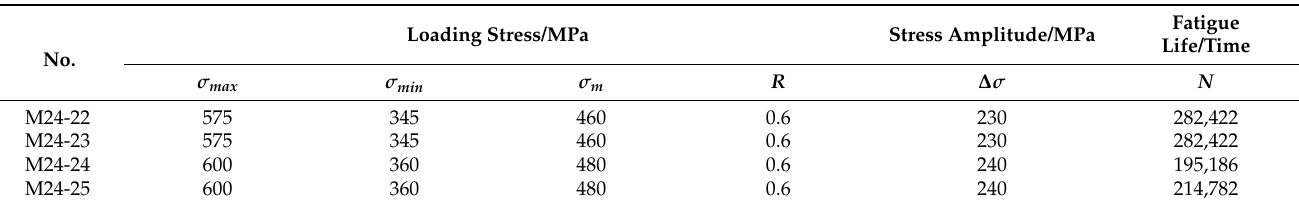
Table 8. Constant amplitude fatigue test results of M24 torsional shear-type high-strength bolt with pretension ( σ max = 575–600